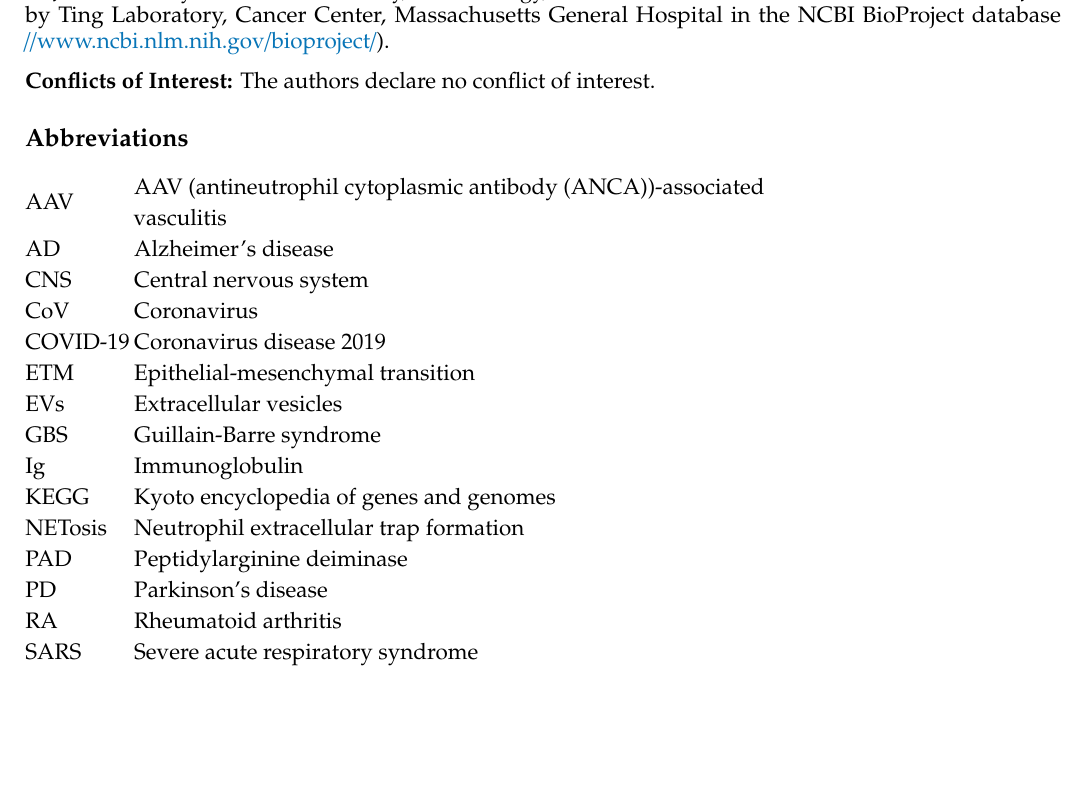
Figure S1: PAD1 expression in control lung biopsies and COVID-19 autopsies, Figure S2: PAD2 expression in control lung biopsies and COVID-19 autopsies, Figure S3: PAD3 expression in control lung biopsies and COVID-19 autopsies, Figure S4: PAD4 expression in control lung biopsies and COVID-19 autopsies, Figure S5: PAD6 expression in control lung biopsies and COVID-19